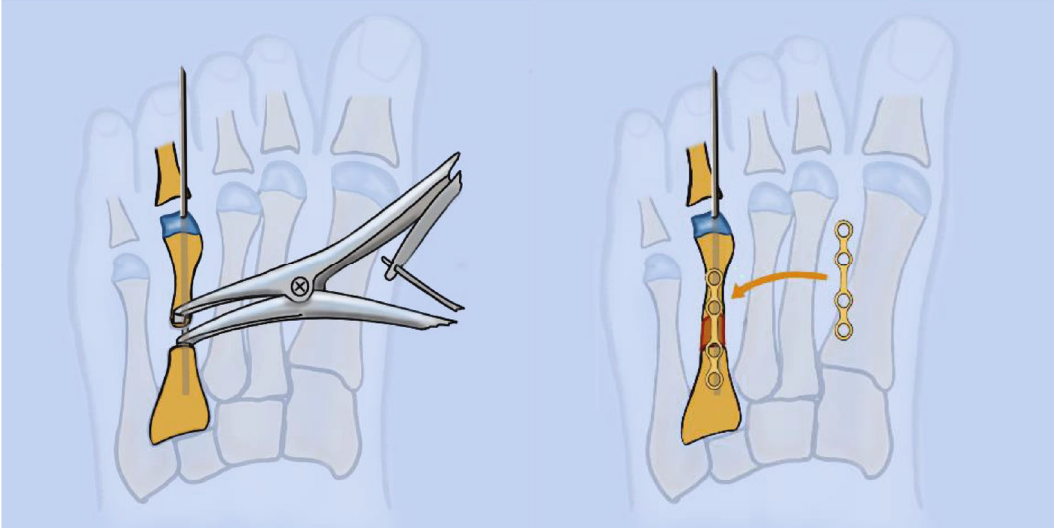
Figure 1: Illustration showing correction of fourth toe brachymetatarsia. (a) Distraction of the bone with cloward after shaft osteotomy after insertion of a 1.2mm K-wire. (b) Iliac bone graft placed in the osteotomy and fi xation with a LCP foot plate locked by screws.